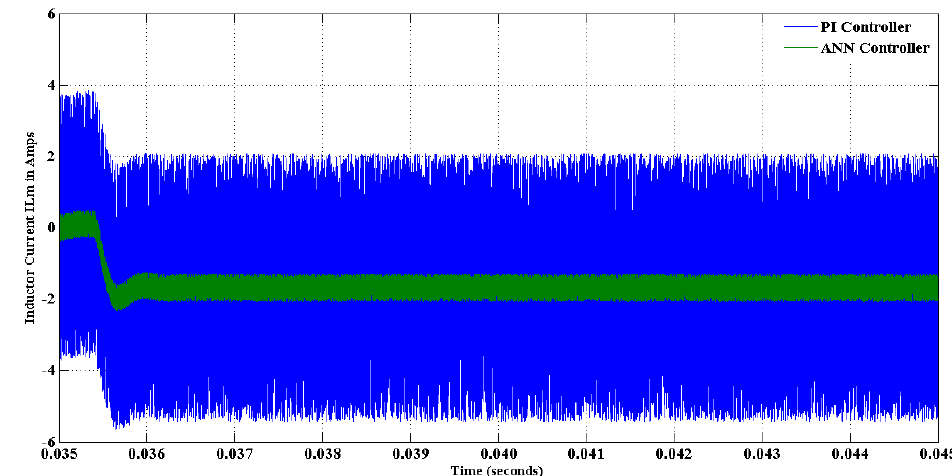
Figure 22. Regulated current step variations in inductor currents at dual low voltage sources.